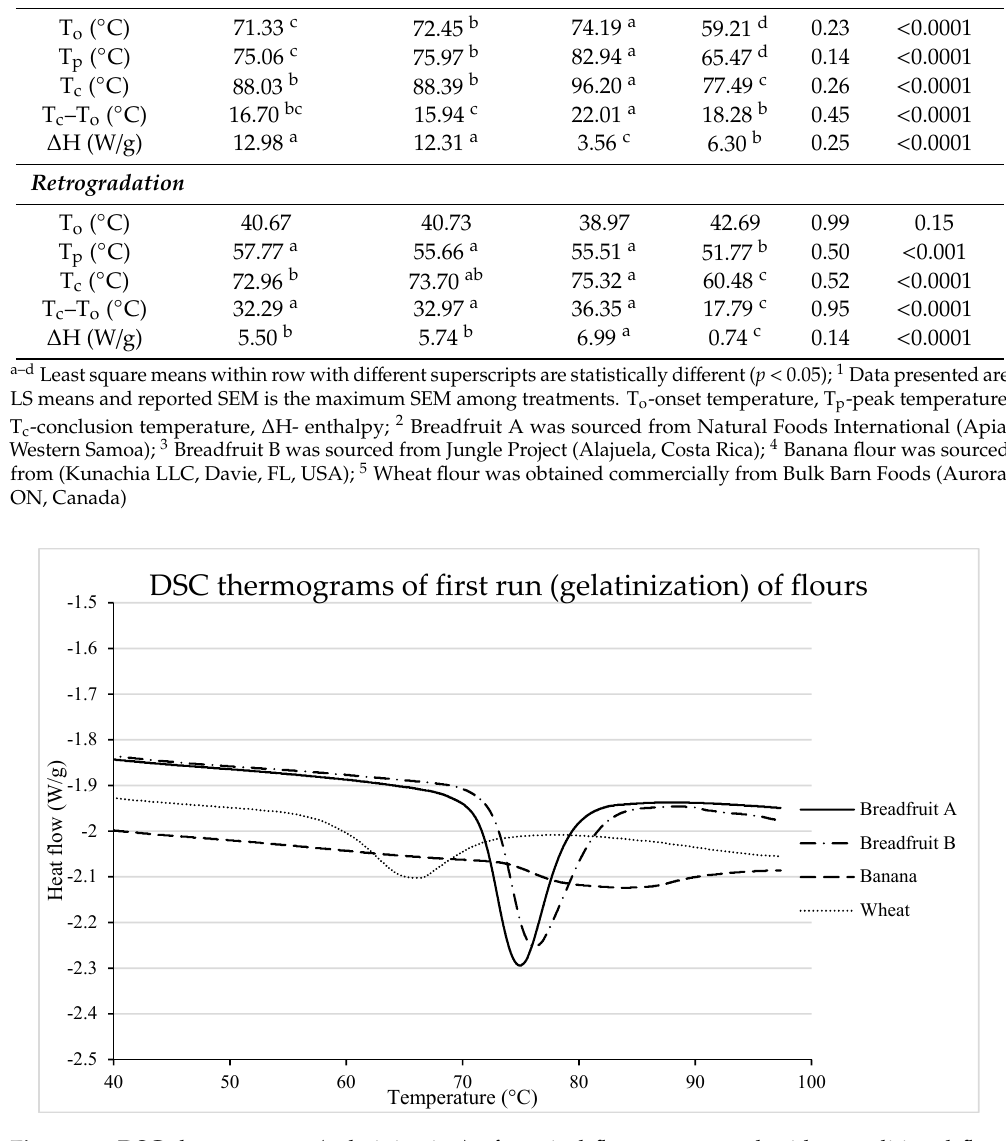
Figure 2. DSC thermograms (gelatinization) of tropical flours compared with a traditional flour. Treatments were flour types of breadfruit A, breadfruit B, banana, or wheat. Breadfruit flour A was sourced from Natural Foods International (Apia, Western Samoa). Breadfruit flour B was sourced from Jungle Project (Alajuela, Costa Rica). Banana flour was sourced from LiveKuna, Kunachia LLC